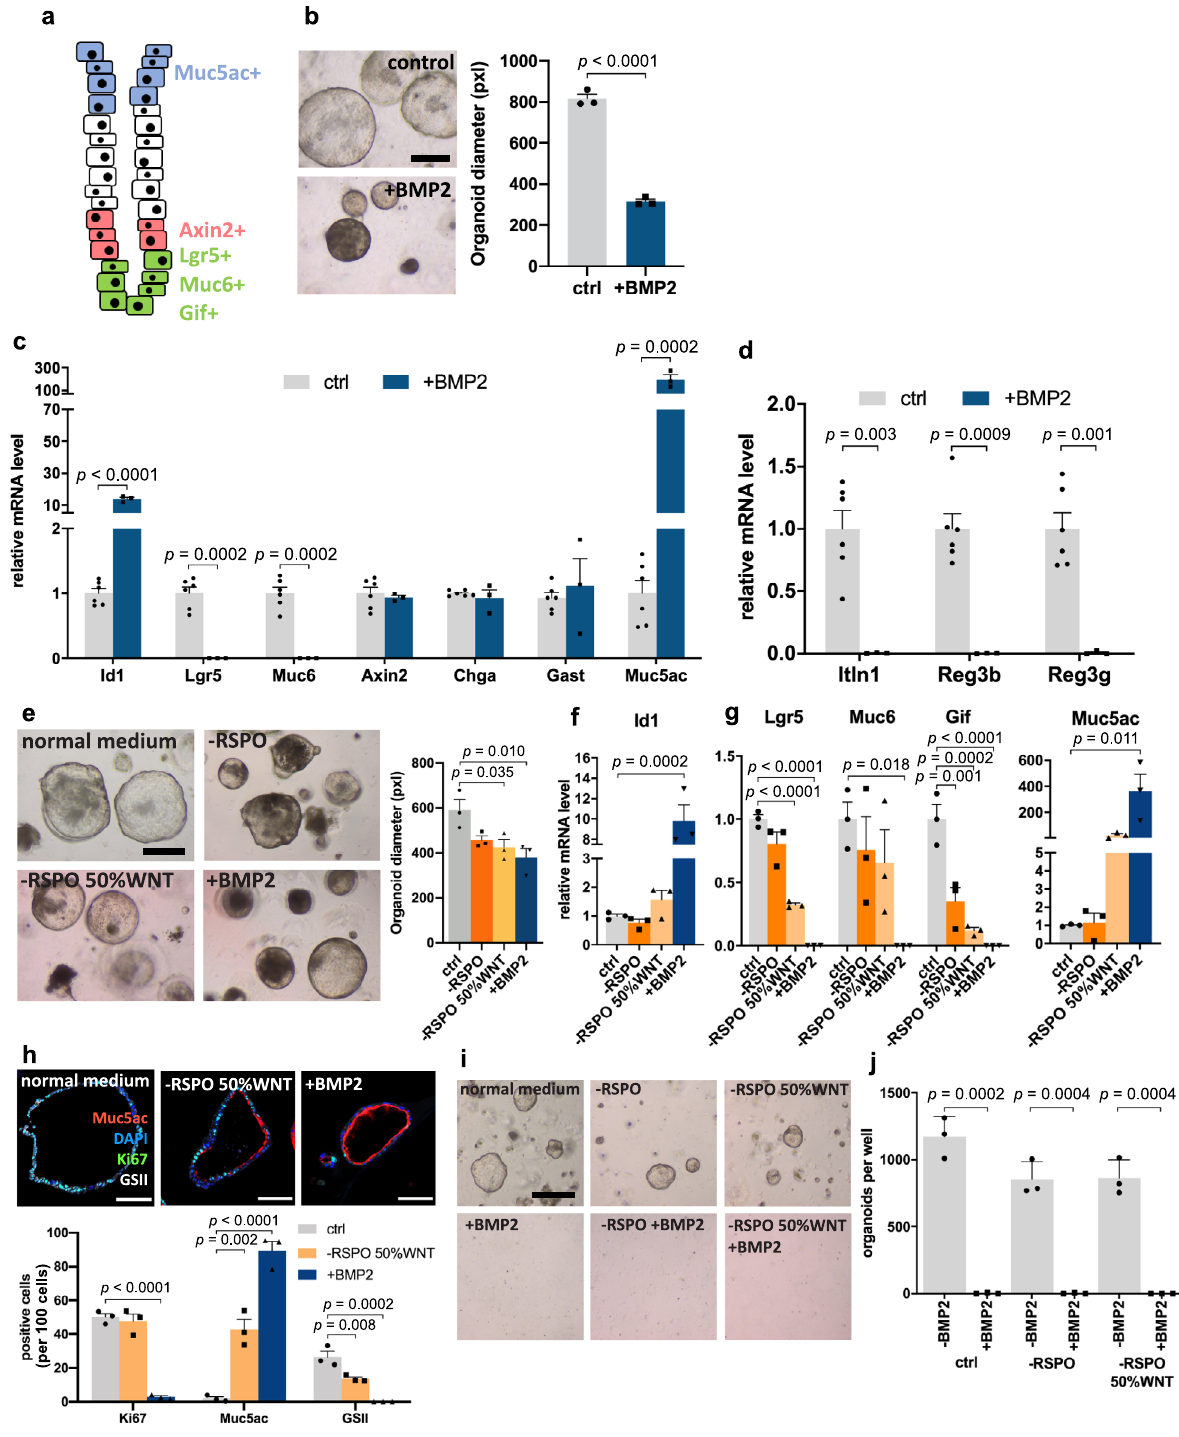
reduced by 90.7% (Fig. 6a), which was associated with a signi fi cant decrease of Bmp2 expression in the glands (Fig.